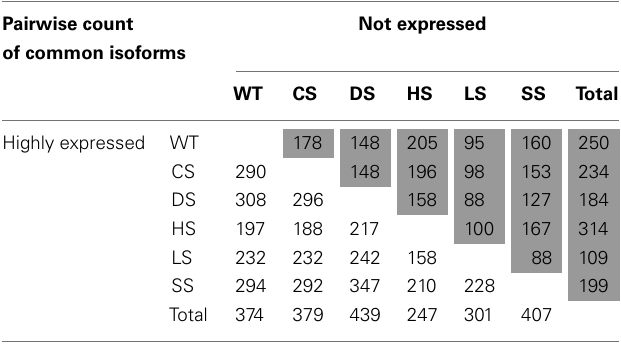
Table 1 | Pairwise comparison of condition-specific lists of isoforms with high and low expression, with high and low expression as defined in the text (normalization method used: global).